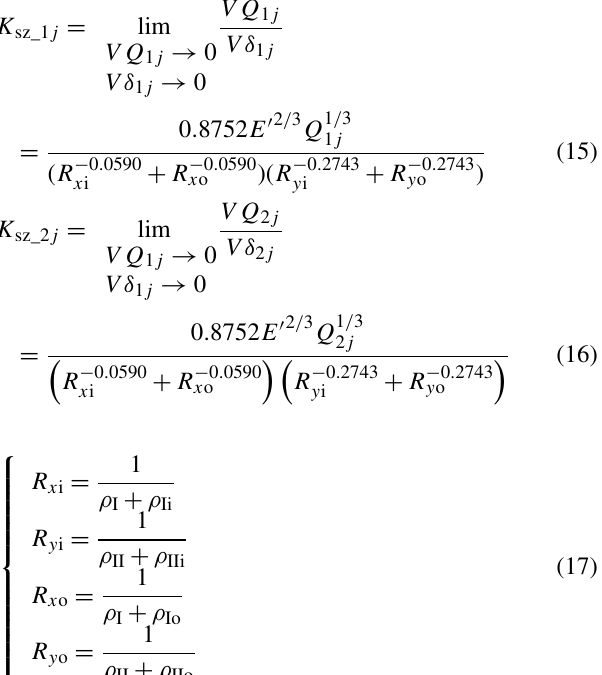
Figure 12. Mechanics analysis of spherical roller